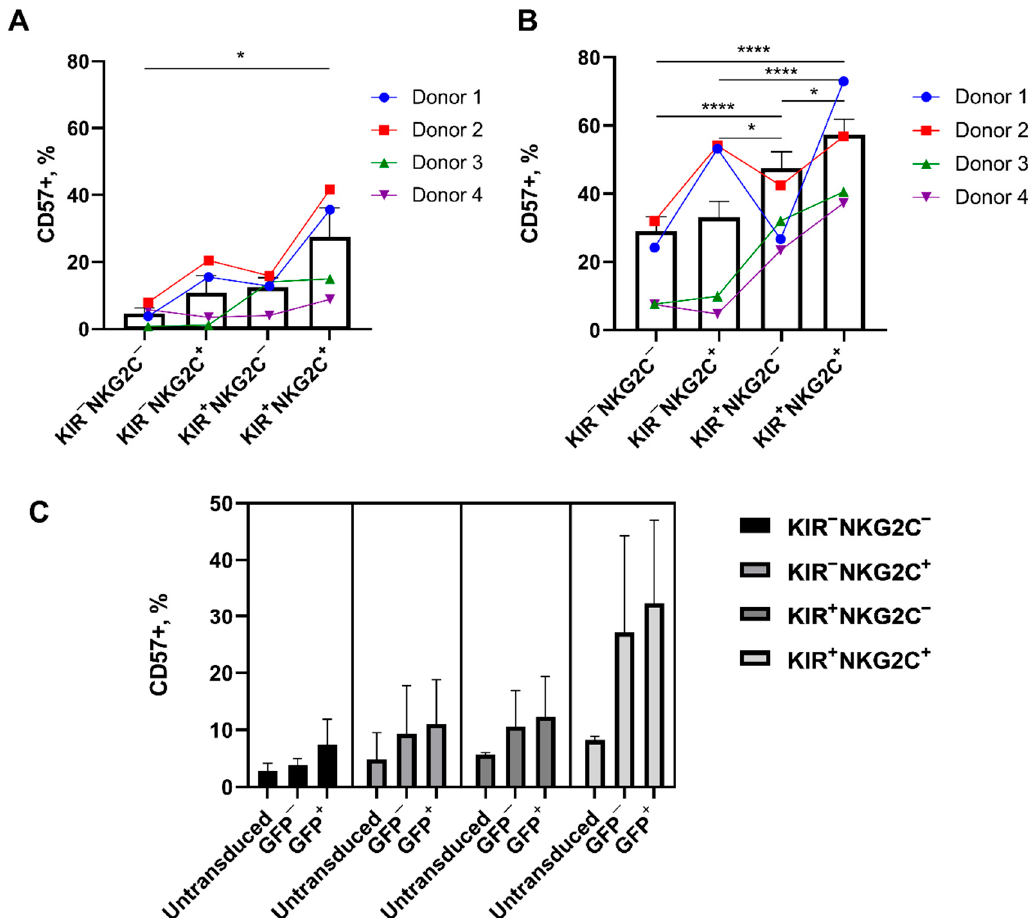
Figure 5. The proportion of CD57 + NK cells ex vivo—in the cultures obtained after stimulation with K562-mbIL21 and IL-2 before the transduction and in the cultures of the transduced cells. ( A ) The proportion of CD57 + NK cells in cultures derived from CD57-negative subpopulations differing in the expression of KIR2DL2/3 and NKG2C after 7 days of stimulation with K562-mbIL21 and IL-2; mean ± SE and individual values of 4 donors selected for transduction experiments are shown. ( B ) The proportion of CD57 + cells ex vivo in NK subpopulations differing in the expression of KIR2DL2/3 and NKG2C from 17 healthy donors (bars, averaged), and from the 4 donors selected for transduction experiments (colored dots and lines). ( C ) The proportion of CD57 + cells in the cultures of untransduced, non-effectively transduced (GFP − ), and effectively transduced (GFP+) NK cells from the subpopulations that initially did not express CD57 and differed in the expression of NKG2C and KIR2DL2/3, 7 days after the transduction, n = 3. ( A – C ) Statistical analysis was performed using a paired t -test (* p < 0.05; **** p < 0.0001). Columns present means ± SE. Data of the individual donors are shown by the lines.